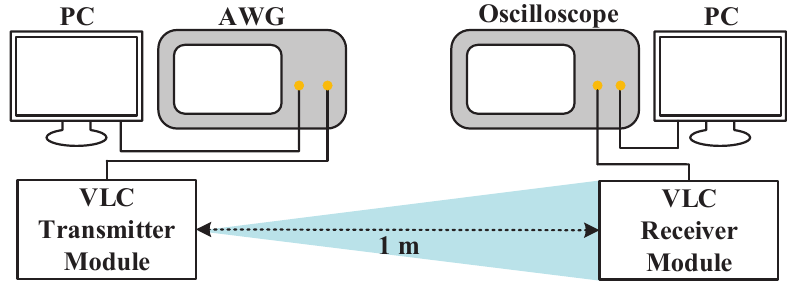
Figure 8. Experimental setup of the NOMA VLC